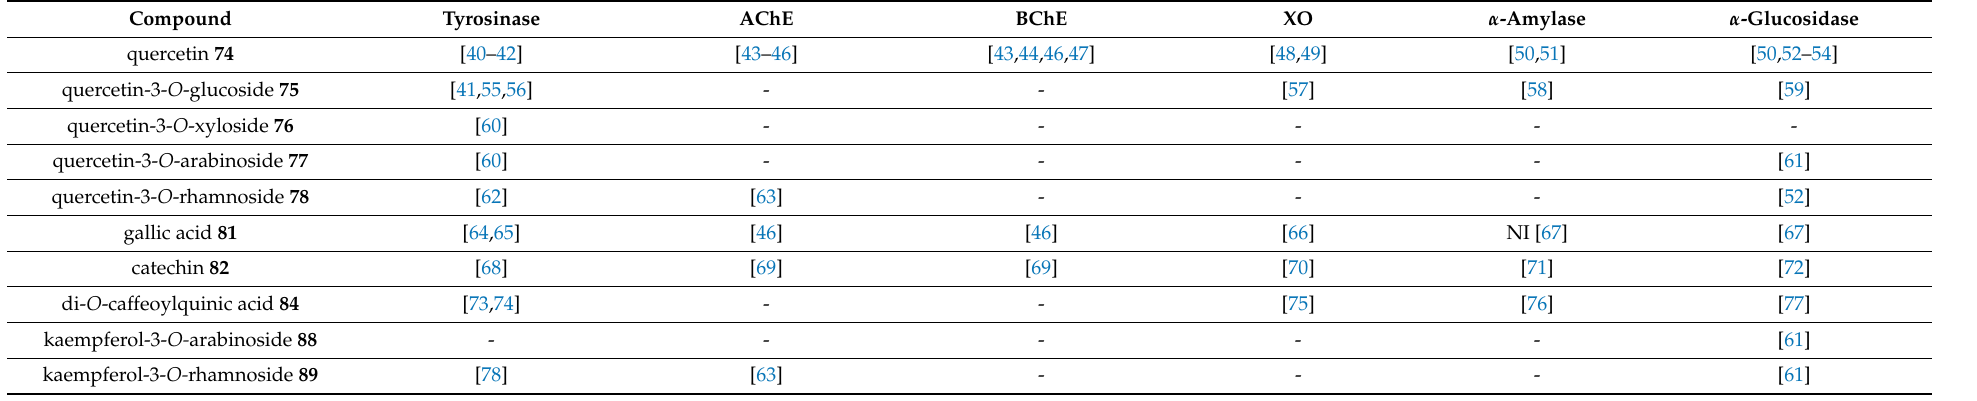
Table 6. Compounds identified in E. characias flower and leaf ethanolic extracts with referred inhibitory